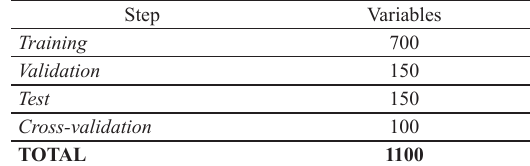
Table 5. Division of